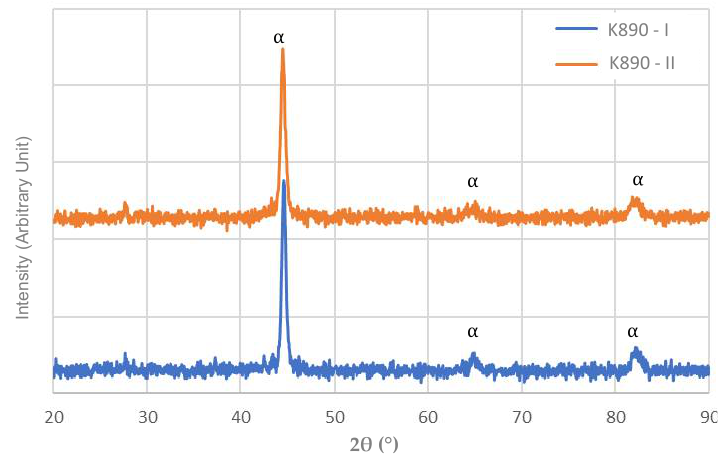
Figure 6. Gaussian distribution of carbides size in K890-I and K890-II specimens. K890-II presents smaller carbides size (peak value) and a more homogeneous (amplitude) carbide distribution.